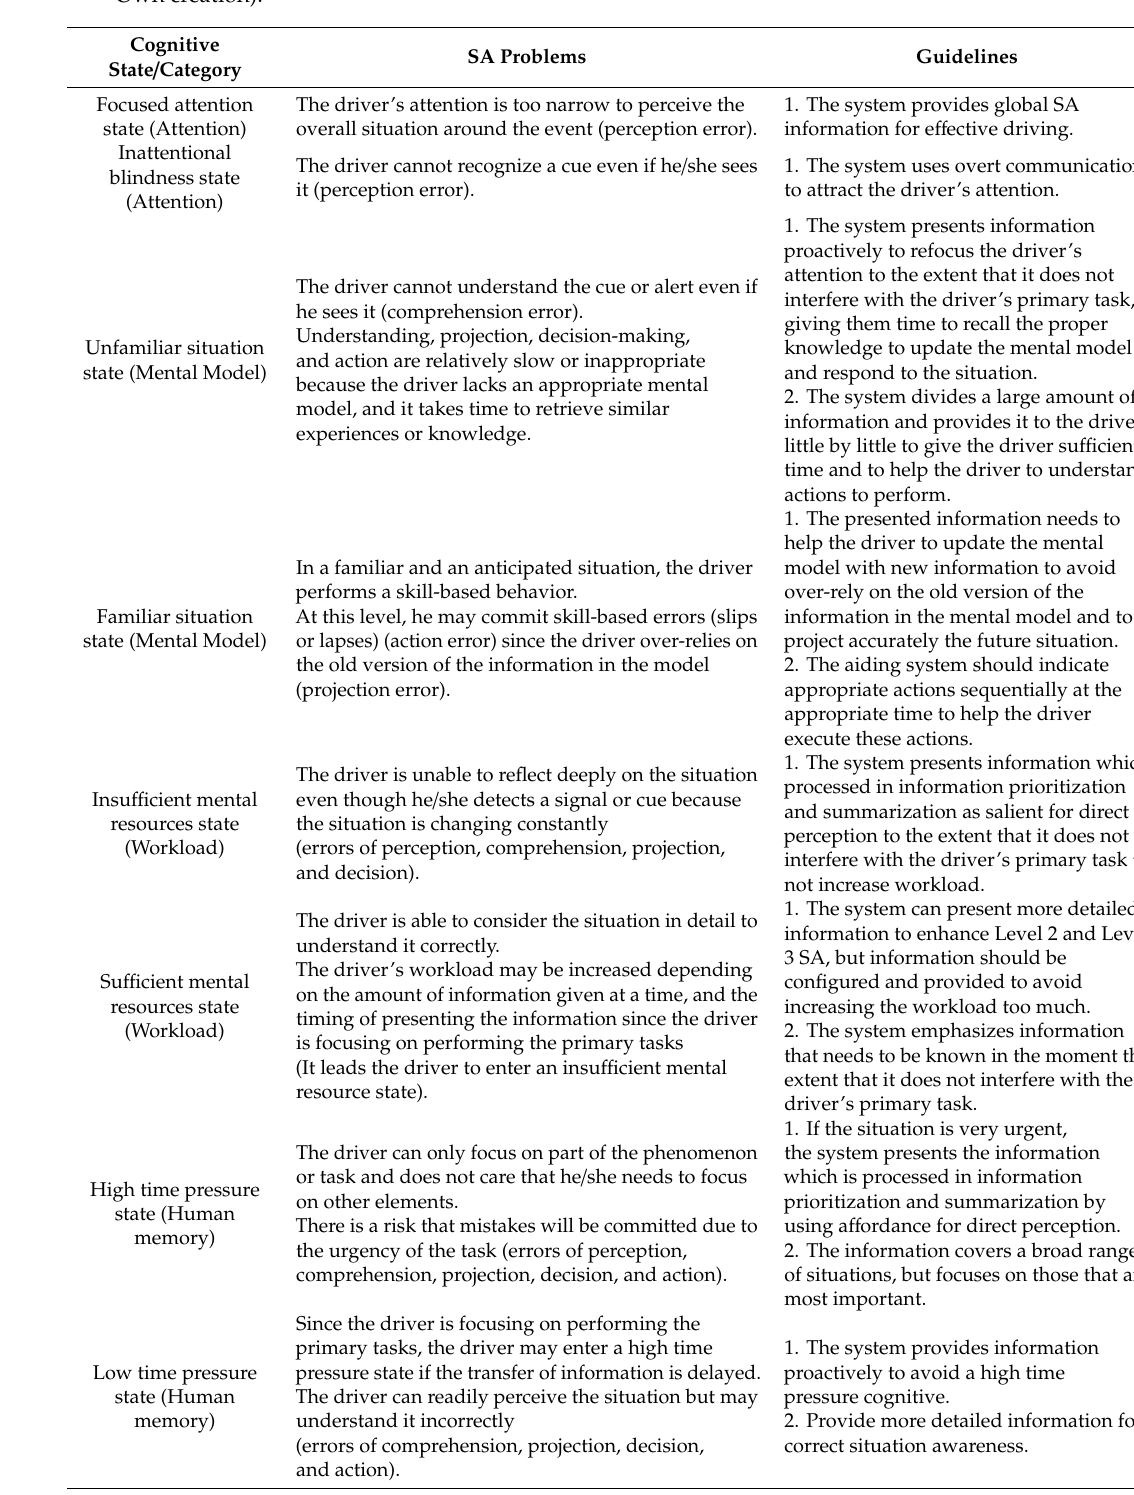
New Situation Awareness Design Principles based on the Cognitive States (Source: Own